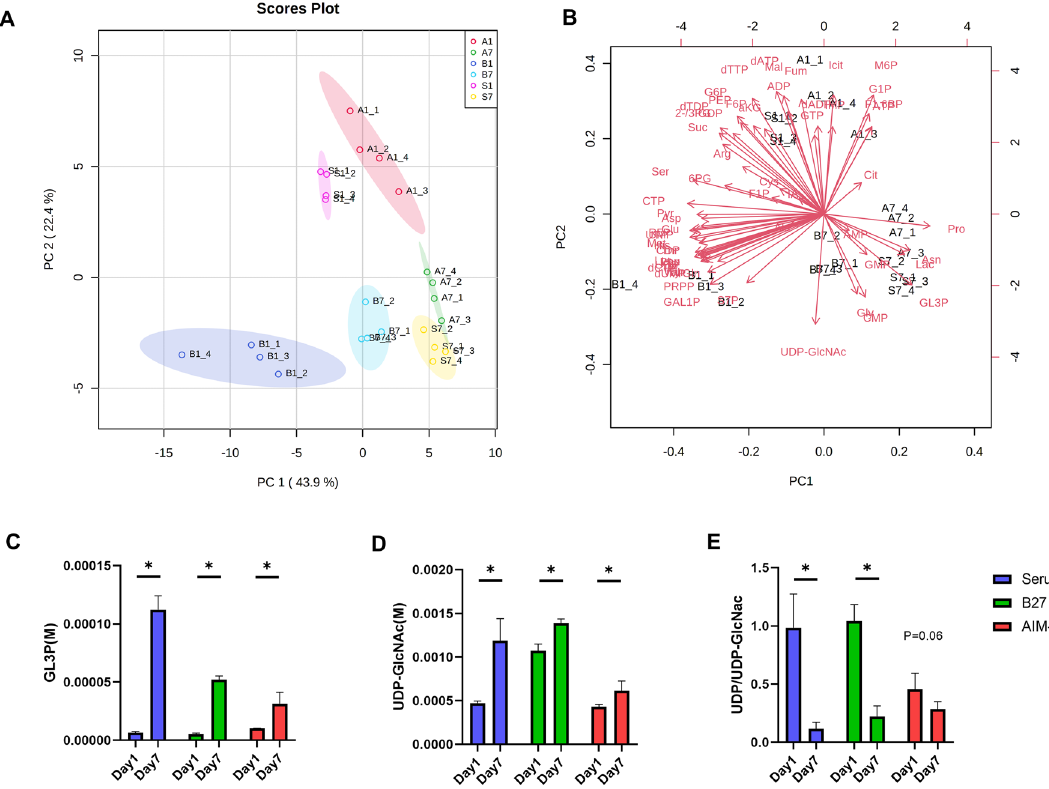
Figure 6. Principle component analysis (PCA) of intracellular metabolites datasets of C2C12 myoblasts (day 1) and myotubes (day 7) cultured in Serum, B27, and AIM-V. ( A ) Score plot of PC2 versus PC1. The individual shaded area presents the 95% confidence interval of the group. ( B ) Biplot. In total, 66% of the data variation is explained by PC1 and PC2. A1, B1, and S1 indicate AIM-V, B27, and Serum culture at day 1, and A7, B7, and S7 indicate AIM-V, B27, and Serum culture at day 7. Significantly increased metabolites in myotubes (day 7) versus myoblasts (day 1) cultured in Serum, B27, and AIM-V mediums. ( C ) Absolute intracellular concentration (M) of GL3P. ( D ) Absolute intracellular concentration (M) of UDP-GlcNAc in Serum, B27, and AIM-V culture. ( E ) The ratio of UDP/UDP-GlcNAc, indicating O-GlcNAcylation. (n) = 4. The student’s t-test was performed to compare day 1 and day 7 in each different culture. *p < 0.05. Data presented as average ± standard deviation